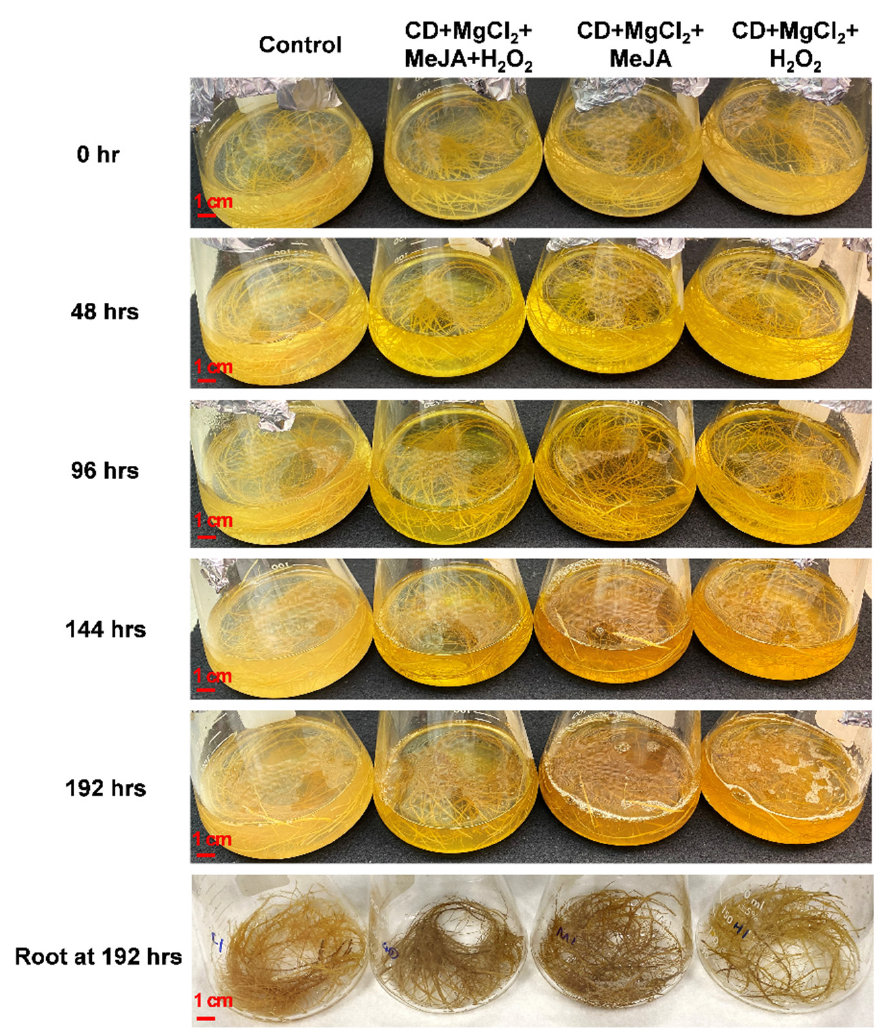
Figure 3. Phenotype of hairy root line U ‐ D2 upon treatment with elicitors for different time periods. The bar in each panel corresponds to 1 cm.